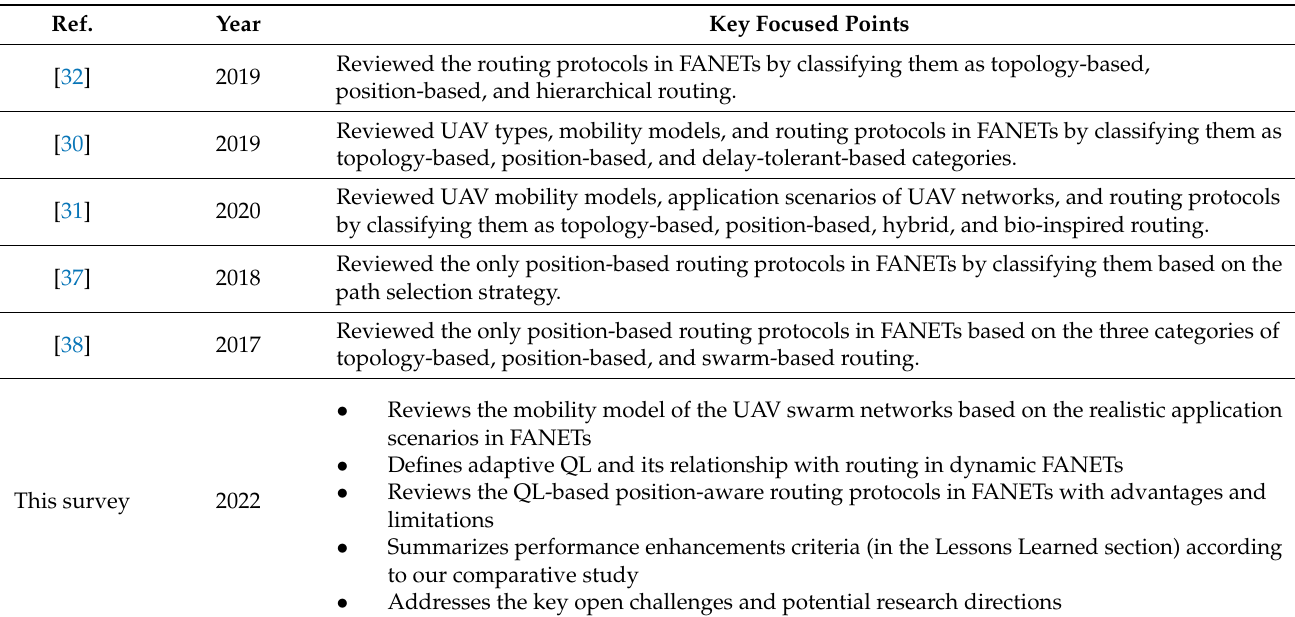
Table 1. Comparative summary of survey works and their focused points on routing in FANETs. Ref. Key Focused